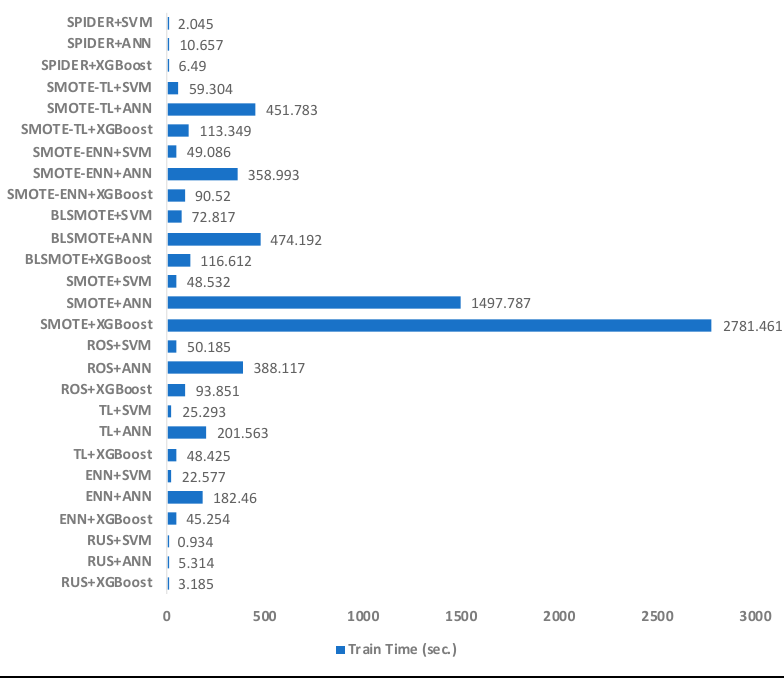
Figure 11. A testing time for all the fusion models.